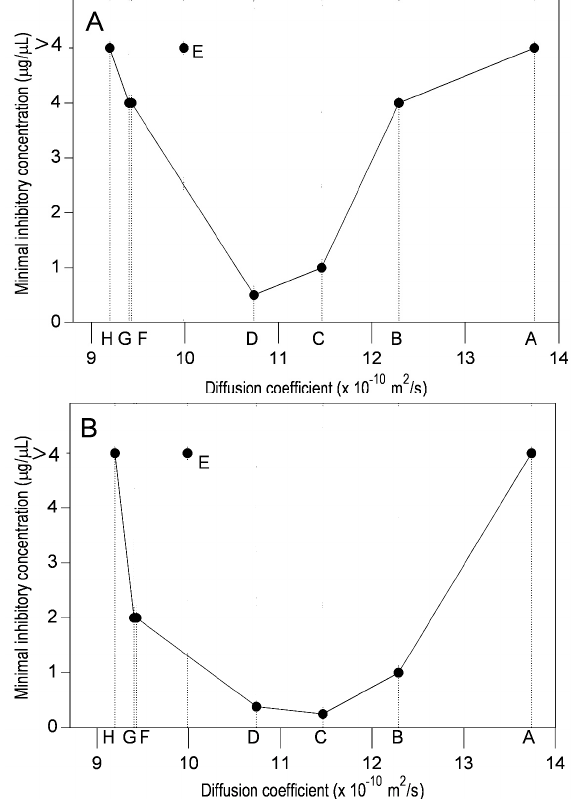
Figure 4. Relation between diffusion coefficient and antibacterial activity of flavonoids. ( A ) E. coli ; and ( B ) B. subtilis . The compounds used were: A (3,7- O -dimethylgalangin), B (pinocembrin), C (galangin), D (3- O -methylgalangin), E (3- O -methylisorhamnetin), F (naringenin), G (7- O -methyleriodictyol), and H (quercetin), which are indicated by small uppercase letters.